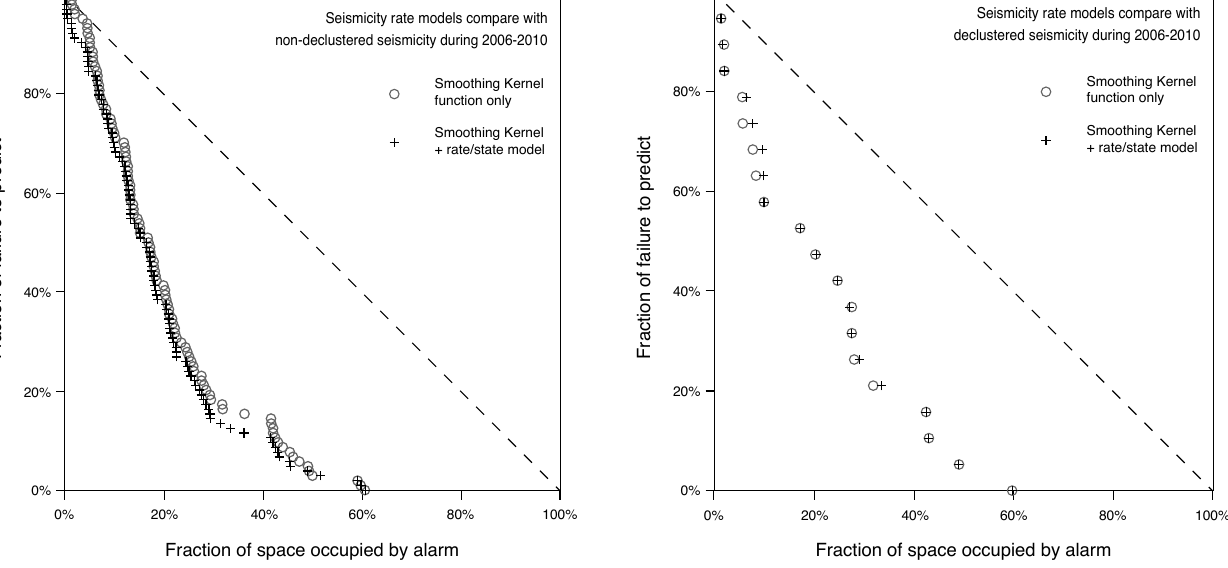
Fig. 10. A Molchan diagram that investigates the correlation be- tween seismicity rate models and declustering seismicity during the forecasting period (2006–2010). Circles represent the correlation of the rate model using the smoothing Kernel function. Crosses repre- sent the correlation of the short-term rate model according to a com- bination of the smoothing Kernel function and the rate-and-state friction